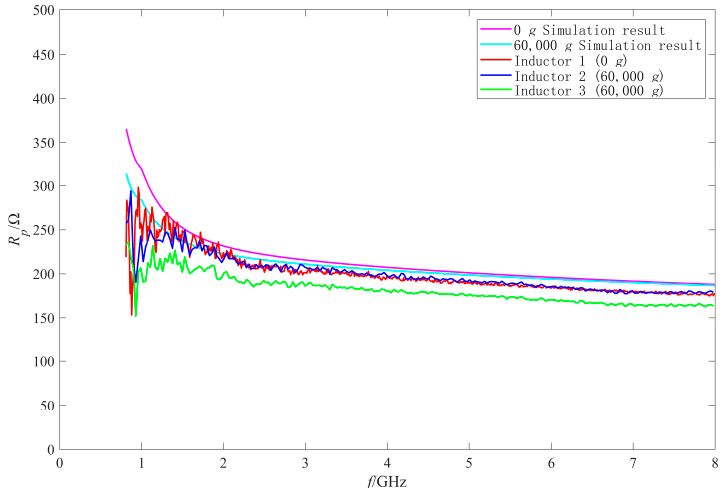
Figure 21. The measured and simulated 𝑅 (cid:3043) of the intact inductors before and after shock test.